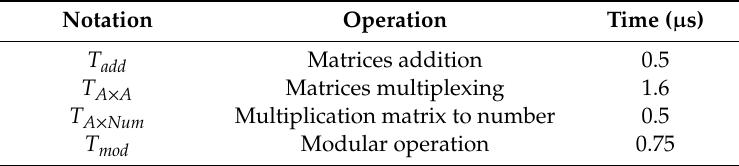
Table 3. Measurement of cryptographic operations (proposed method).